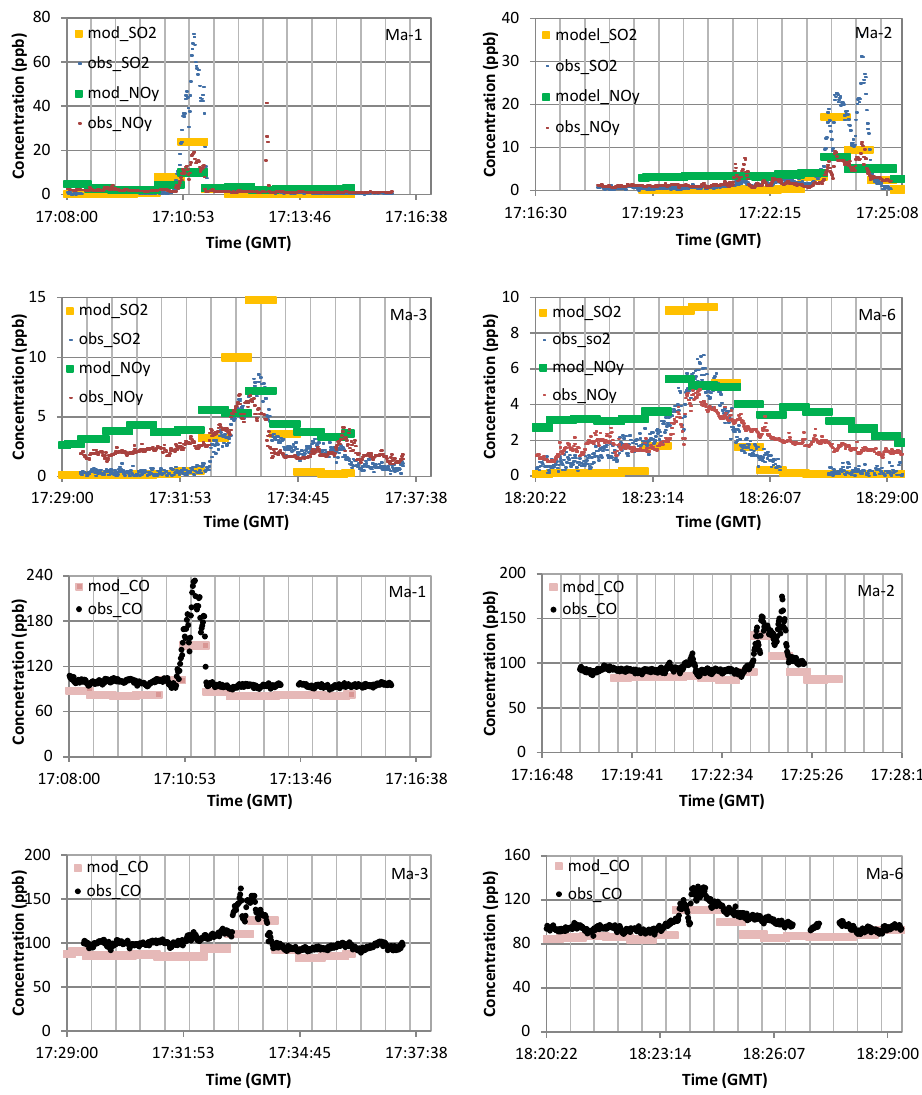
Fig. 3. The comparison of the modeled and observed SO 2 , NO y , and CO at plume transect of Ma-1, Ma-2, Ma-3 and Ma-6. The modeled SO 2 , NO y , and CO are labeled as yellow, green, and purple flat lines, respectively. The observed SO 2 , NO y , and CO are labeled as blue, red and black dots. The Horizontal coordinate is time scale in GMT (local time=GMT − 6h) and vertical coordinate is concentration (ppb). Transect names listed in Table S3 of the manuscript are labled in each subplot. Figures S1–S4 summarize the comparisons for all the plume